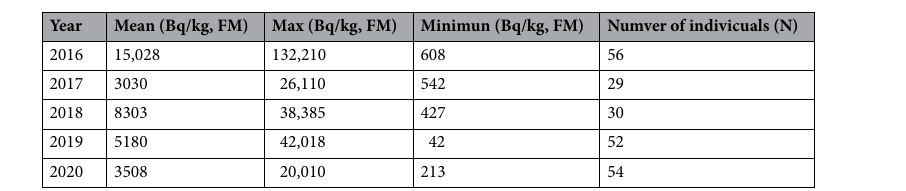
Table 1. 137 Cs activity concentration in wild boars muscle of each year in difficult to return